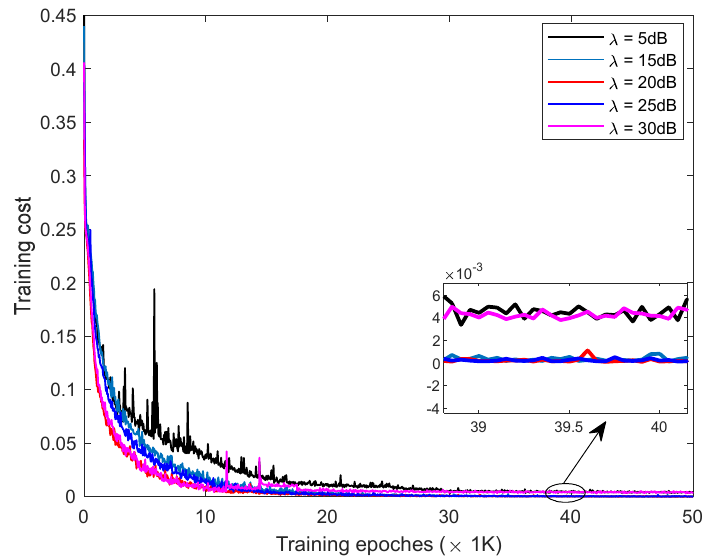
Figure 4. The cost performance comparison for different training SNRs under the LOS case.